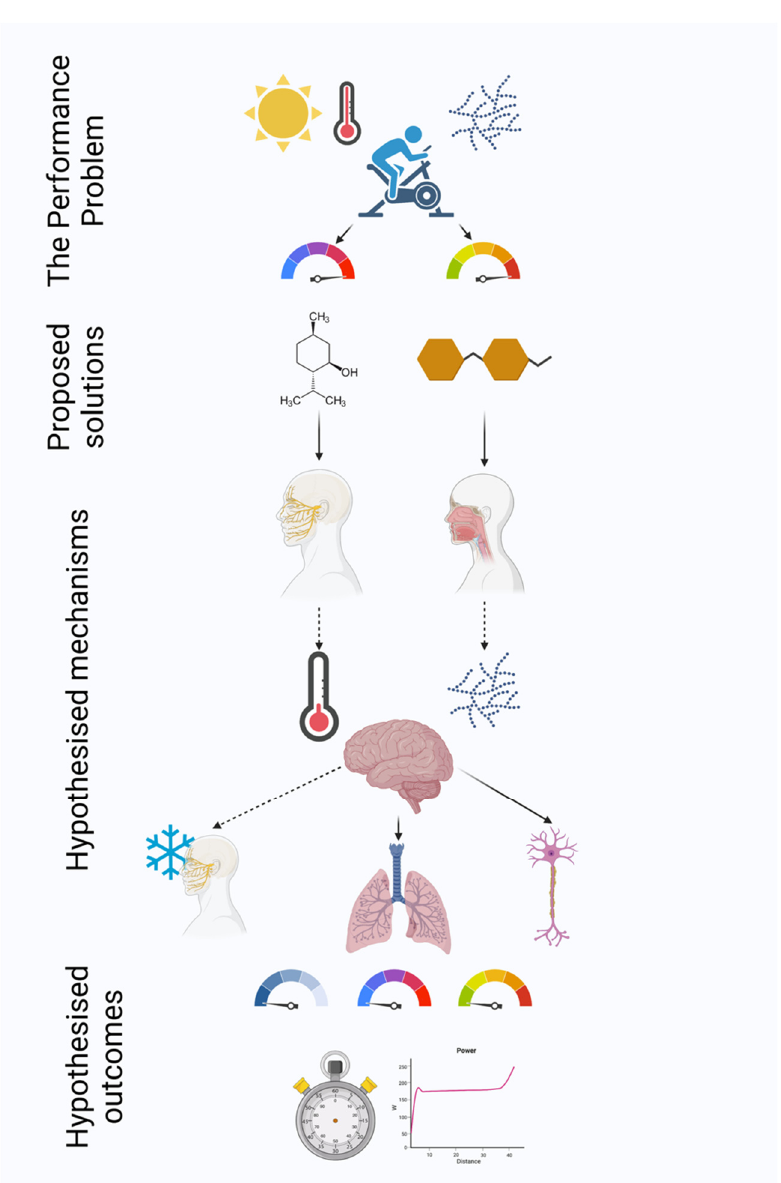
Figure 1. The performance of endurance exercise in the heat with solar radiation imposes consider- able glycogen depletion, with the environmental conditions serving to increase thermal sensation(s) and ratings of perceived exertion (the performance problem). Proposed solutions to this are menthol and carbohydrate administration or a combination of both solutions. When swilled, these solutions stimulate oral cold receptors and the trigeminal nerve and oral carbohydrate receptors, respectively. In turn, this may lower perceived temperature (menthol) and increase perceived fuel availability (carbohydrate). The brain may then interpret these signals, imparting a localised cooling effect, al- tering ventilatory mechanics or increasing central drive. These mechanisms may then improve per- ceptions of local cooling, full-body thermal sensation or RPE (left to right dials), translating to im- provements in time trial performance via maintenance of a greater power output during exercise (hypothesised outcomes). Dashed arrows indicate perceptual drivers, whereas solid arrows indicate objectively measurable drivers. Created with BioRender.com(accessed on 30 September 2021).